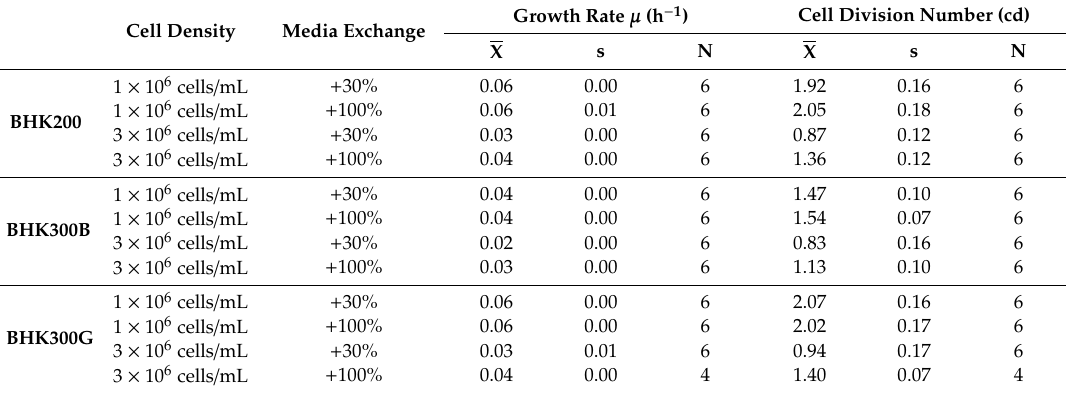
Table 1. Calculation of the cell-specific growth rate and cell division.